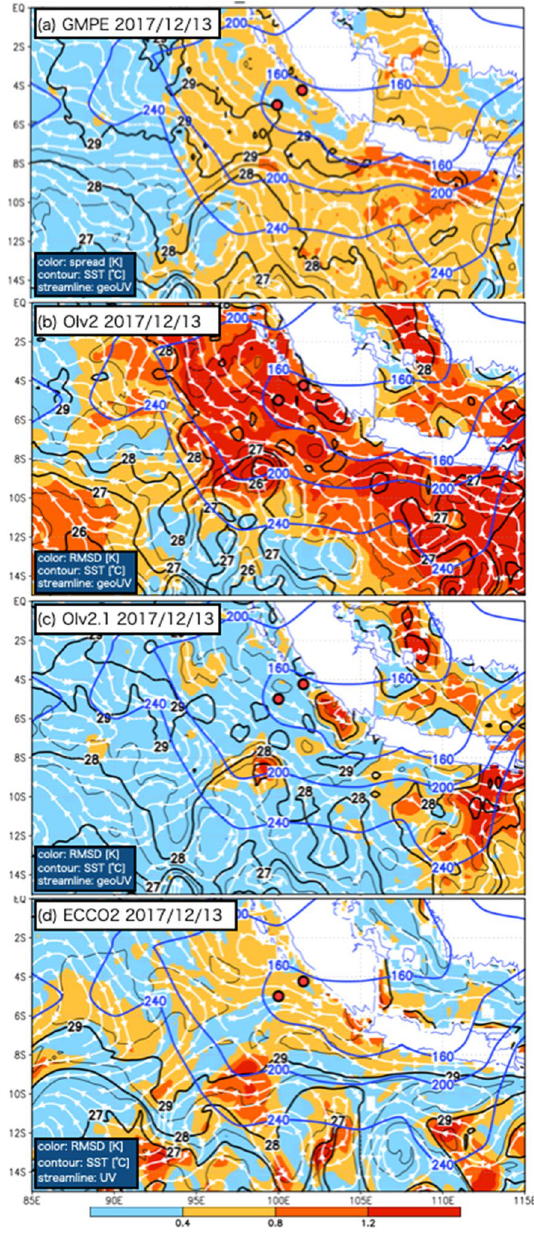
Figure 5. The estimated error (colored) as the ( a ) GMPE ensemble standard deviation, ( b ) RMSD of OIv2 with respect to GMPE, ( c ) RMSD of OIv2.1 with respect to GMPE, and ( d ) RMSD of ECCO2 with respect to GMPE on 13 Dec. 2017. The black contours (every 0.5 K is indicated with thin contours, and every 1 K is indicated with bold contours) show SST from ( a ) GMPE, ( b ) OIv2, ( c ) OIv2.1, and ( d ) ECCO2. The white streamlines indicate the surface current from ( a )–( c ) the geostrophic current calculated from SSH and ( d ) ECCO2. The blue contours show 160, 200, and 240 W/m 2 OLR. The two red circles indicate the locations of the Sumatra buoy and R/V Mirai